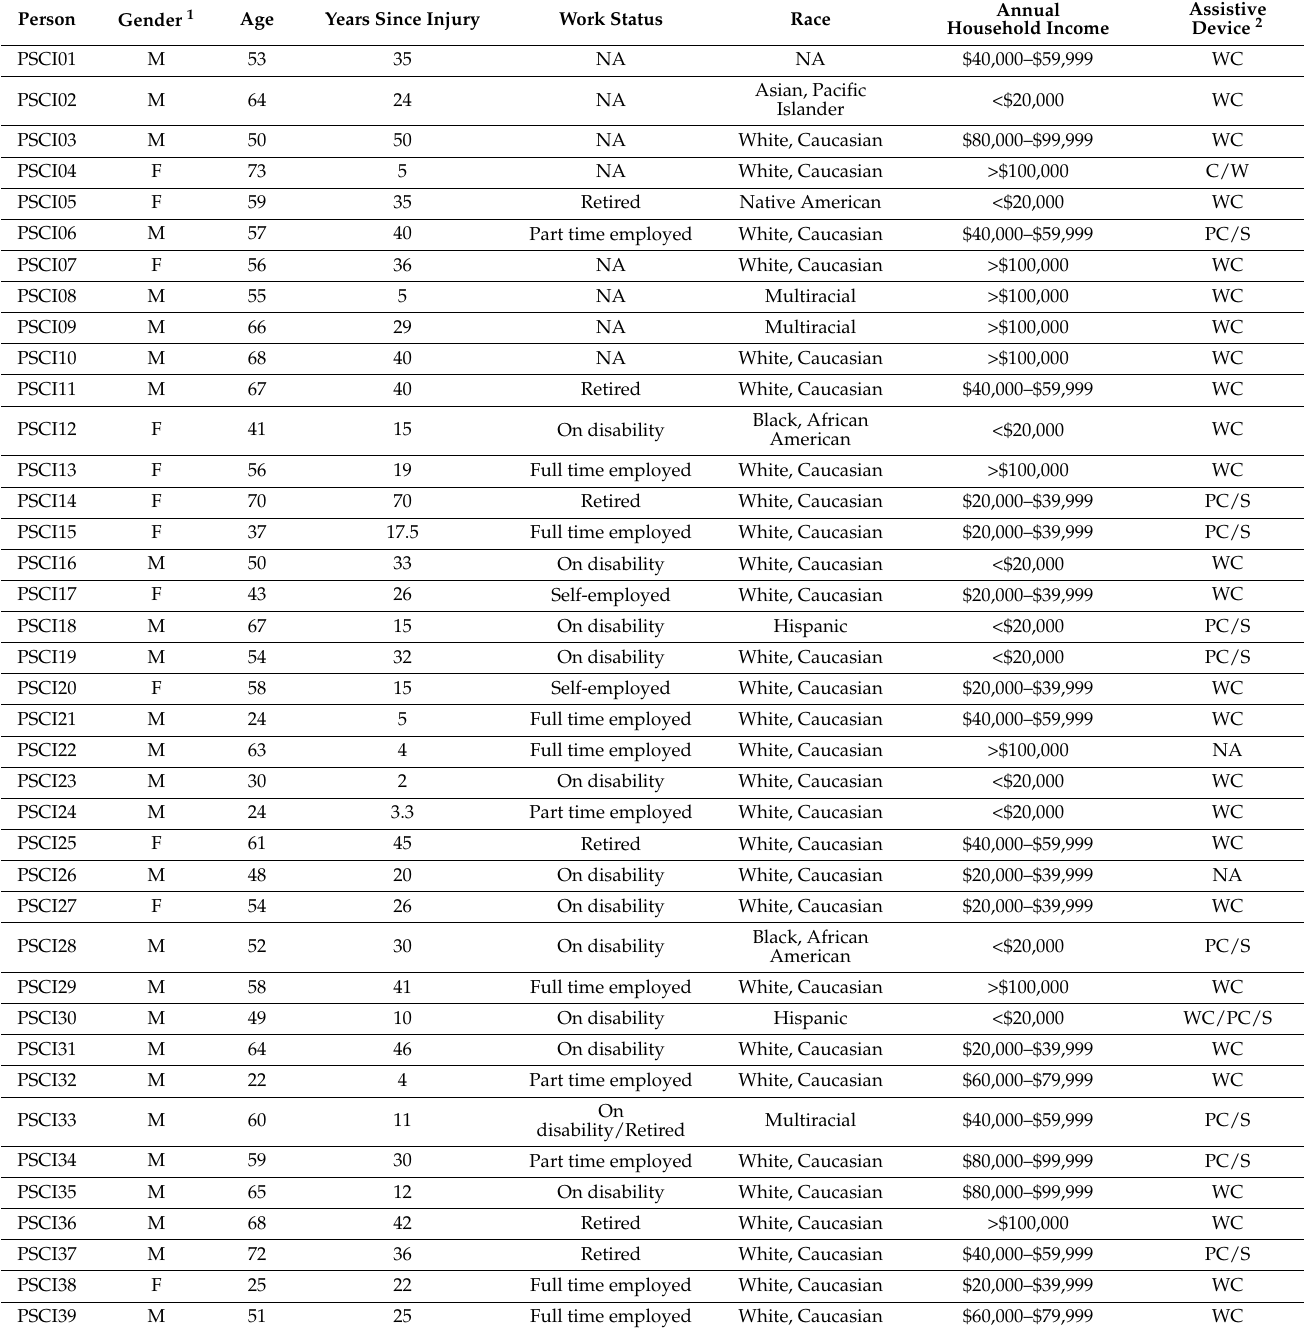
Table 1. Demographic and Injury Characteristics of Qualitative Research